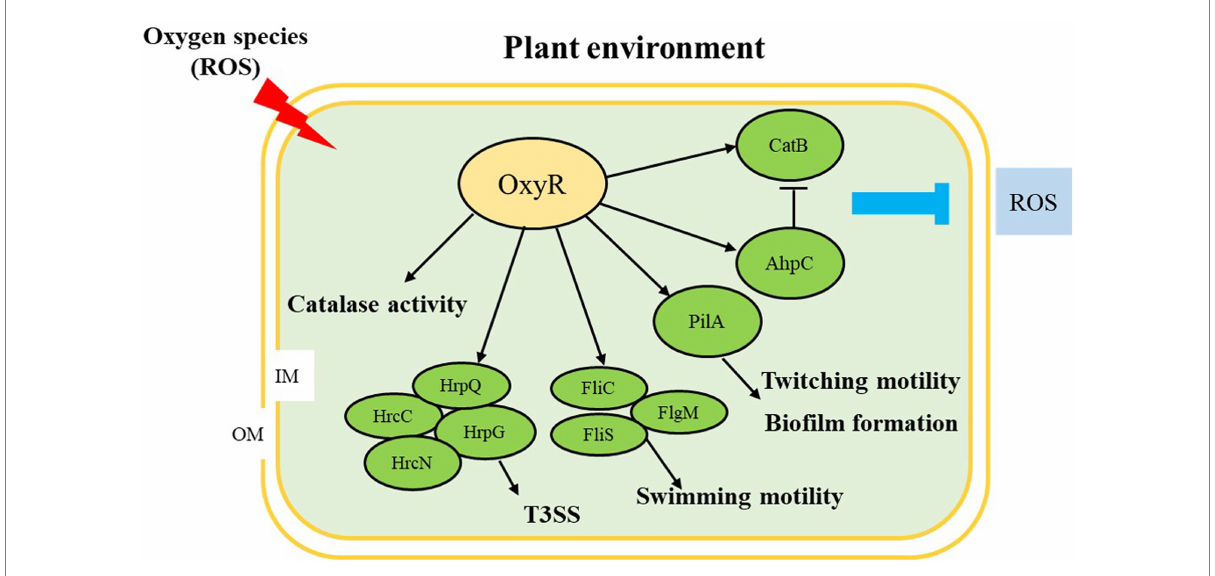
FIGURE 7 Proposed model illustrating the global effect of OxyR in Acidovorax citrulli . ↓ , positive regulation; ⊥ , negative regulation; OM: outer membrane; IM: inner membrane; ROS: reactive oxygen species; T3SS: type III secretion system. Regulatory steps in the model are mainly at the transcriptional